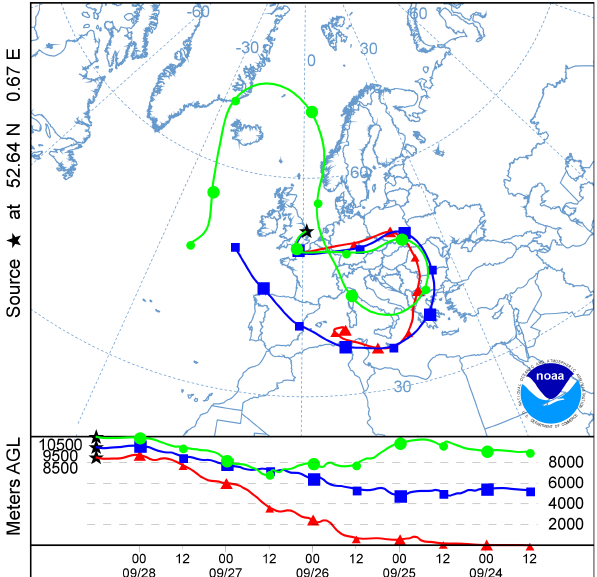
Fig. 2. As Fig. 1 but for cirrus flight B558 ending at 12:00UTC on 28 September 2010, computed for final altitudes of 8500, 9500 and